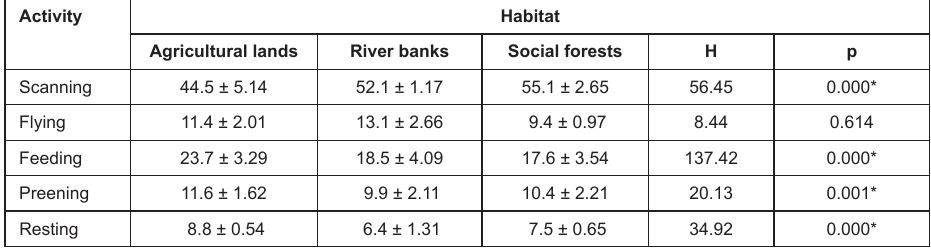
Table 6. Percentage of time spent (mean ± SD) on different activities by Indian Roller according to habitat